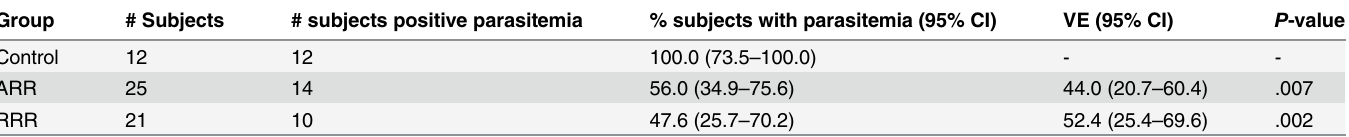
Table 1. Vaccine efficacy against positive blood slide parasitemia after sporozoite challenge (ATP cohort for vaccine efficacy).